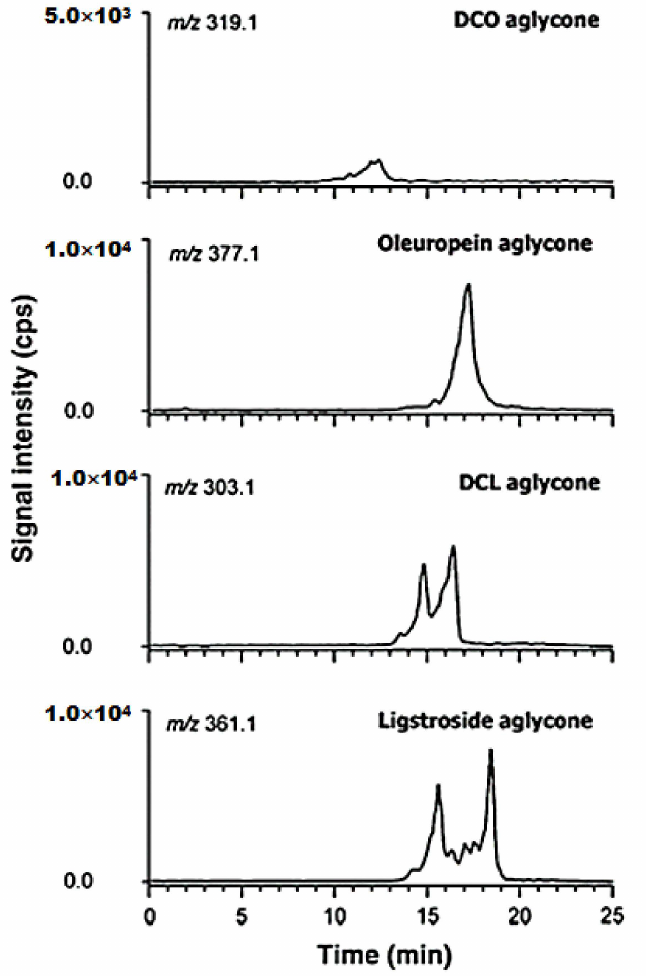
Figure 4. Chromatograms obtained for secoiridoid compounds after the HPLC–ESI( − )–MS analysis of virgin olive oil extracts. Published from [97] with the permission of the